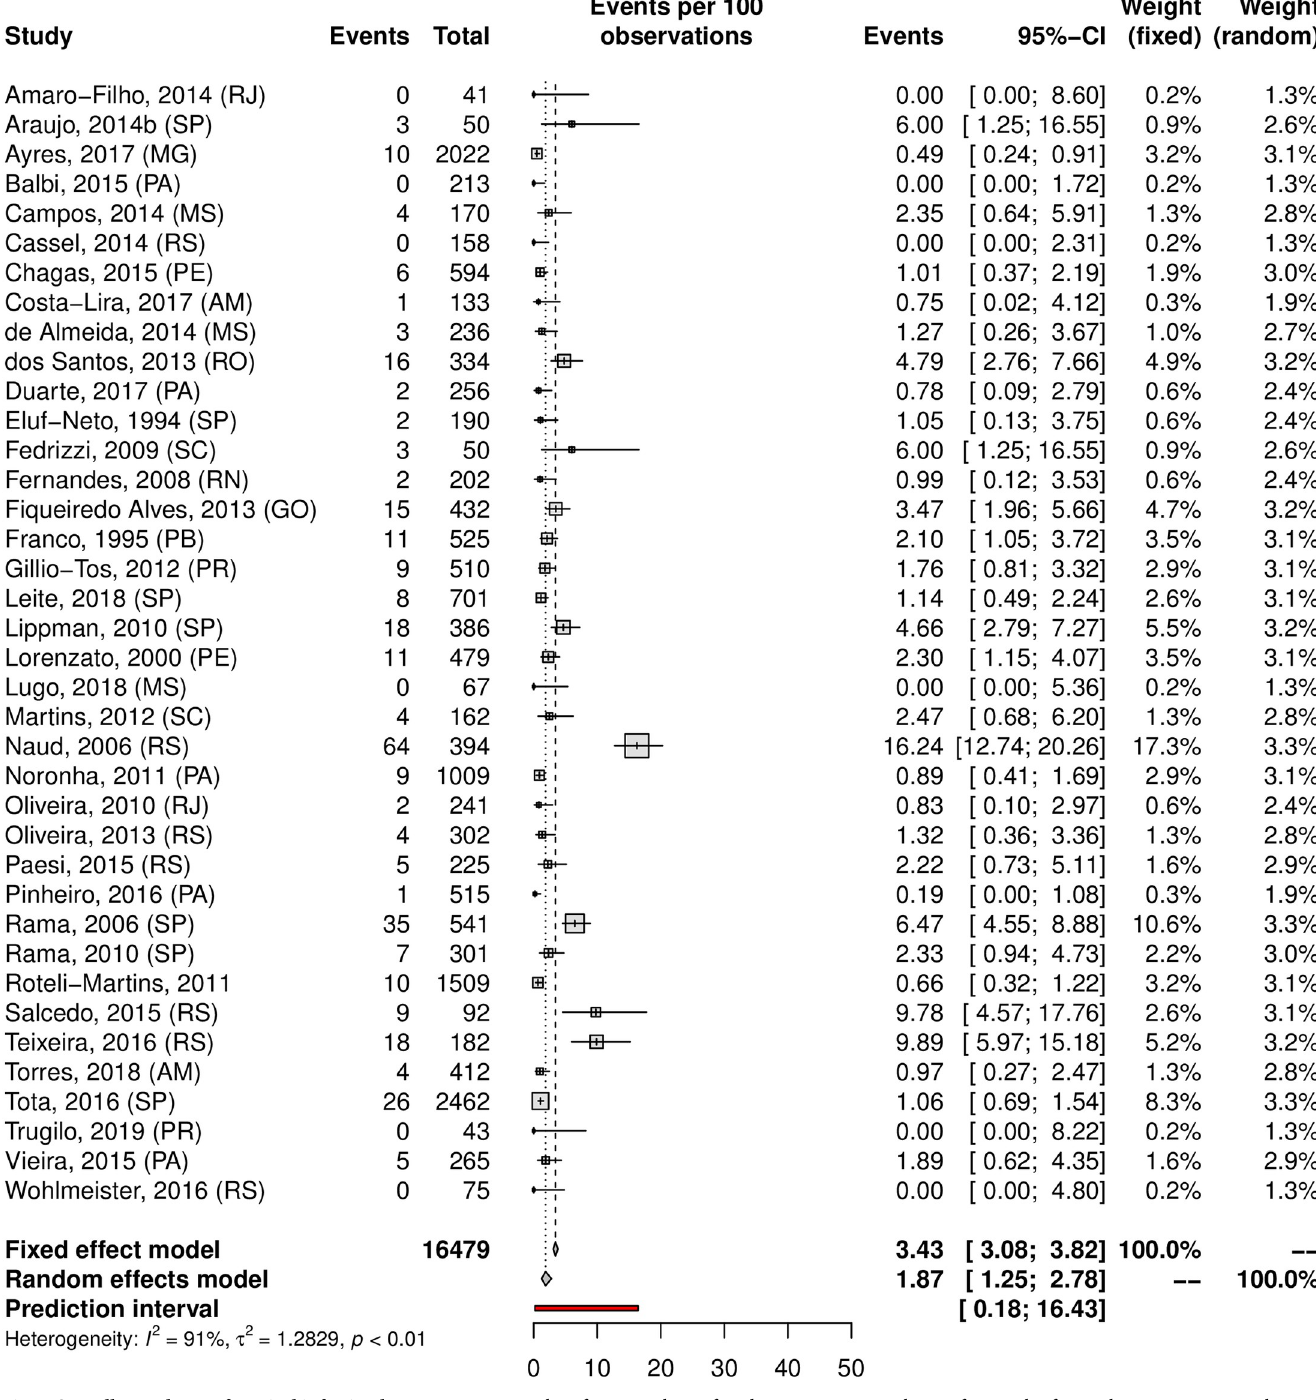
Fig 4. Overall prevalence of cervical infection by HPV-18. Forest plot of a metanalysis of studies reporting prevalence of cervical infection by HPV-18 in